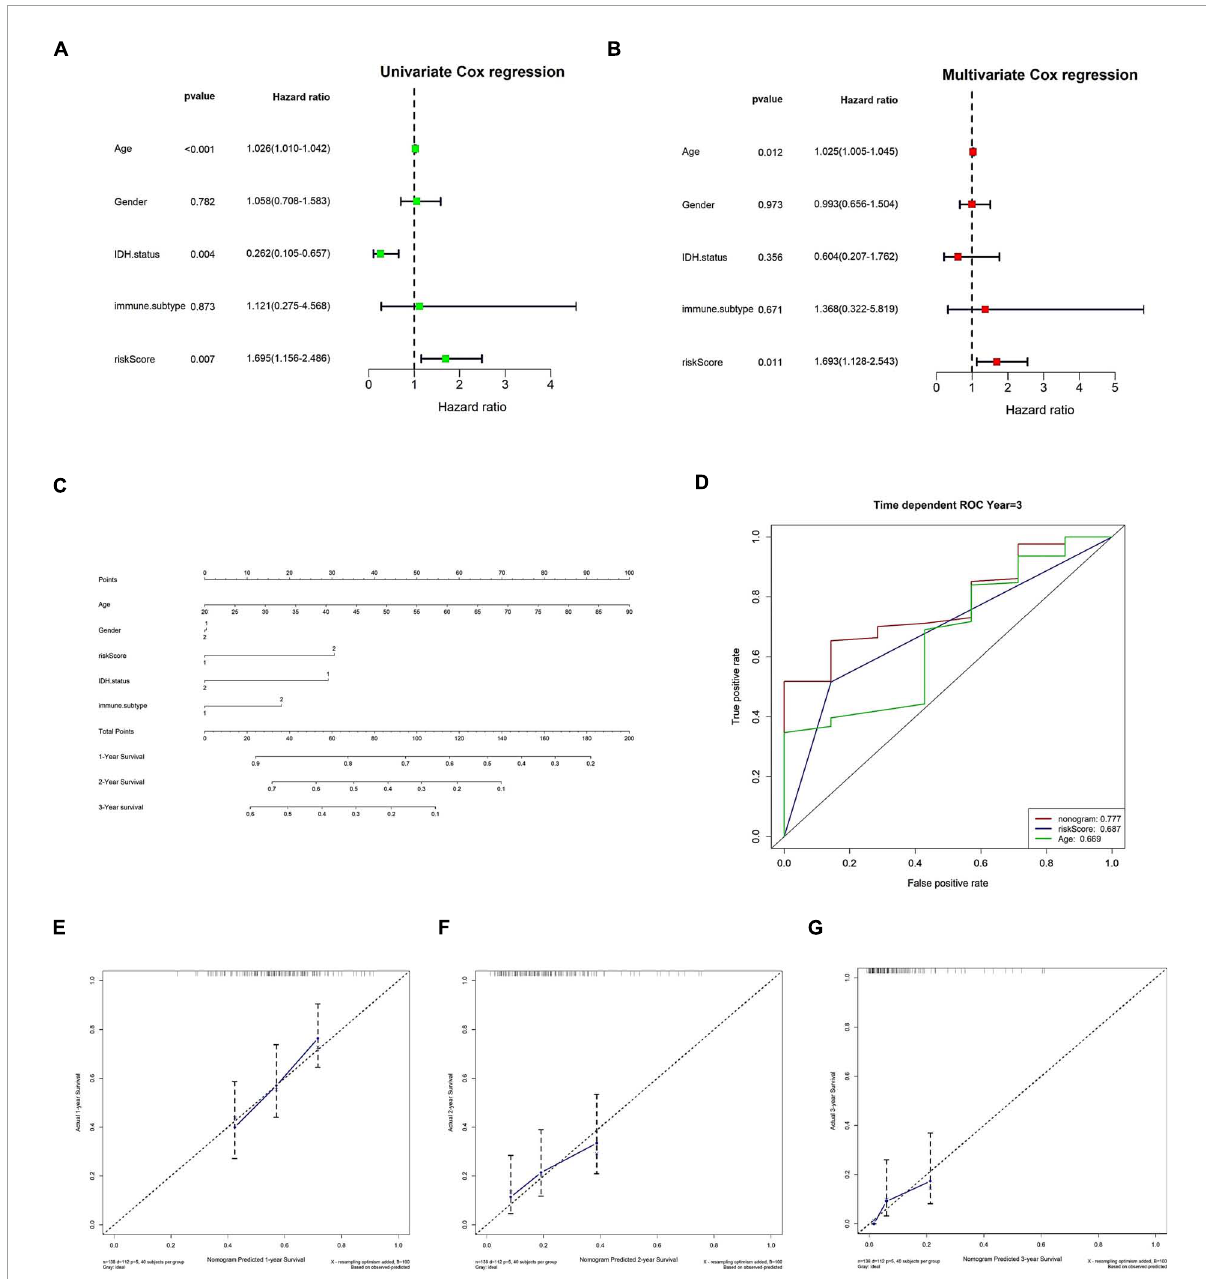
FIGURE8 Clinical information was used to verify risk scores as an independent prognostic factor. (A,B) Independent prognostic factor analysis of risk scores. (A) Univariate Cox analysis. (B) Multivariate Cox analysis. (C–G) Nomograms. (C) Nomogram. (D) The nomogram’s 3-year risk score, stage, and overall ROC curve. (E–G) Calibration curves for 1, 2, and 3 years, respectively. In panel (C) , immune C1 in the immune. The subtype is 1, and immune C4 is 2; in gender, the male is 1 and female is 2; in IDH mutation, WT is 1 and mutant is 2; in risk score, low is 1 and high is